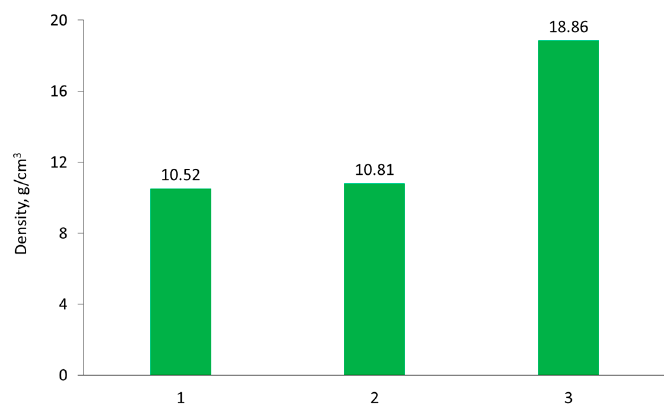
Figure 6. Densities of the compact and sintered 77W-20Re-3Ni alloy: 1—compact; 2—alloy after initial sintering; 3—alloy after vacuum sintering at 1520 °C for one hour. The influence of vacuum-sintering temperature on final product density was also determined.